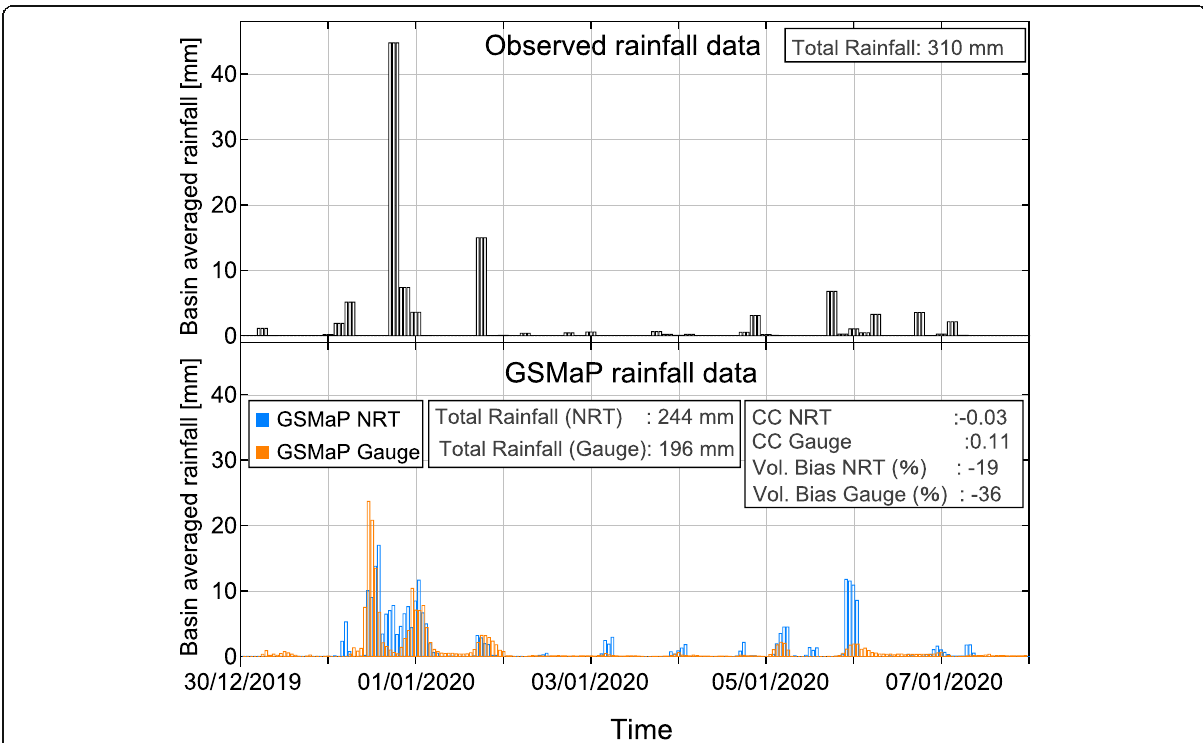
Fig. 4 Comparisons of hourly rainfall between GSMaP products (NRT & gauge.v7) and observation for flood event of 2020